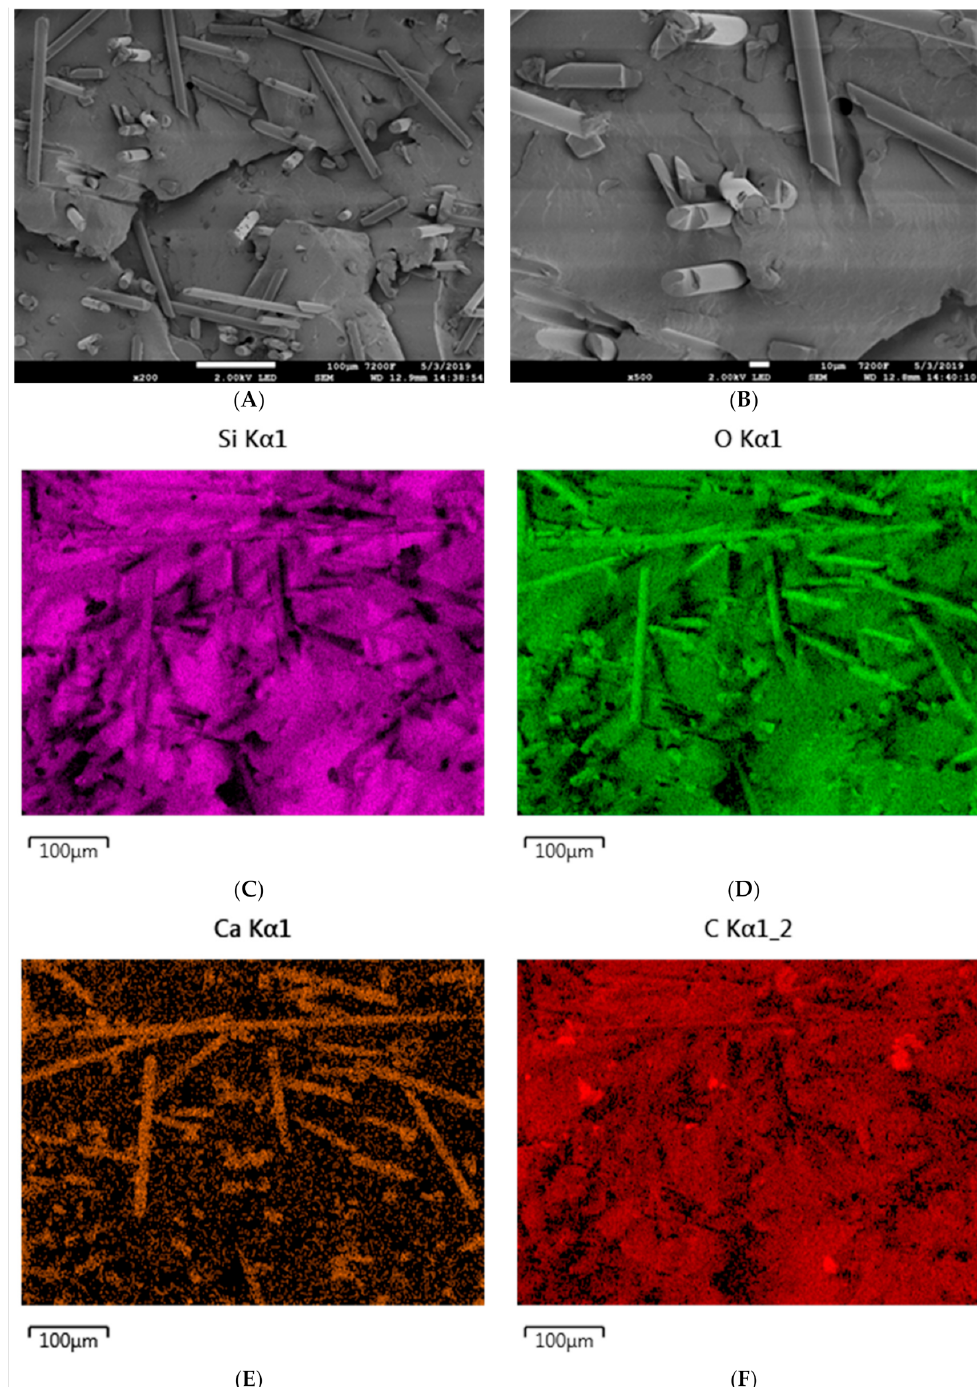
Figure 13. SEM images of the SR-4 composite at magnifications of ( A ) × 200 and ( B ) × 500. EDS mapping of SR-3 ( C ) silicon distribution, ( D ) oxygen distribution, ( E ) calcium distribution, ( F ) carbon